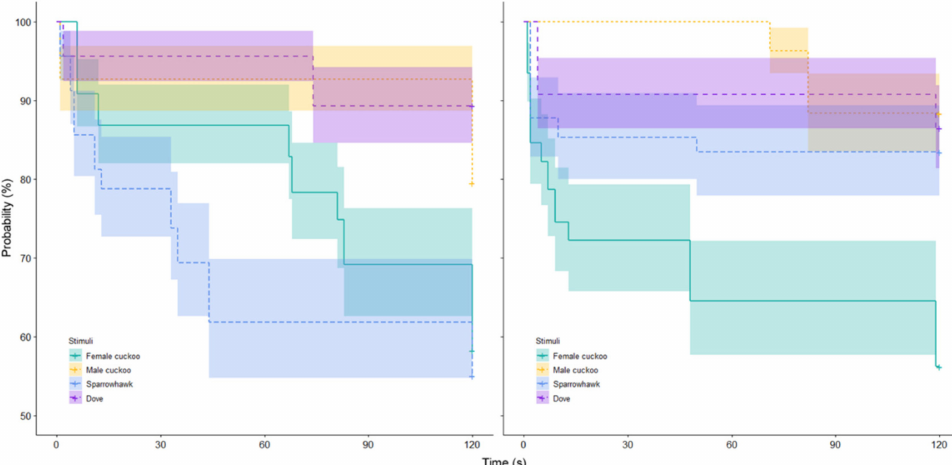
Figure 2. Kaplan–Meier curve (with 95% CI) for the probability of staying on nests by host parents from the playback of stimuli in Yongnian ( left ) and Zhalong ( right ) populations (the vertical axis represents the probability of the host staying in the nest, and the lower the value, the more likely the host is to leave the nest after hearing that specific